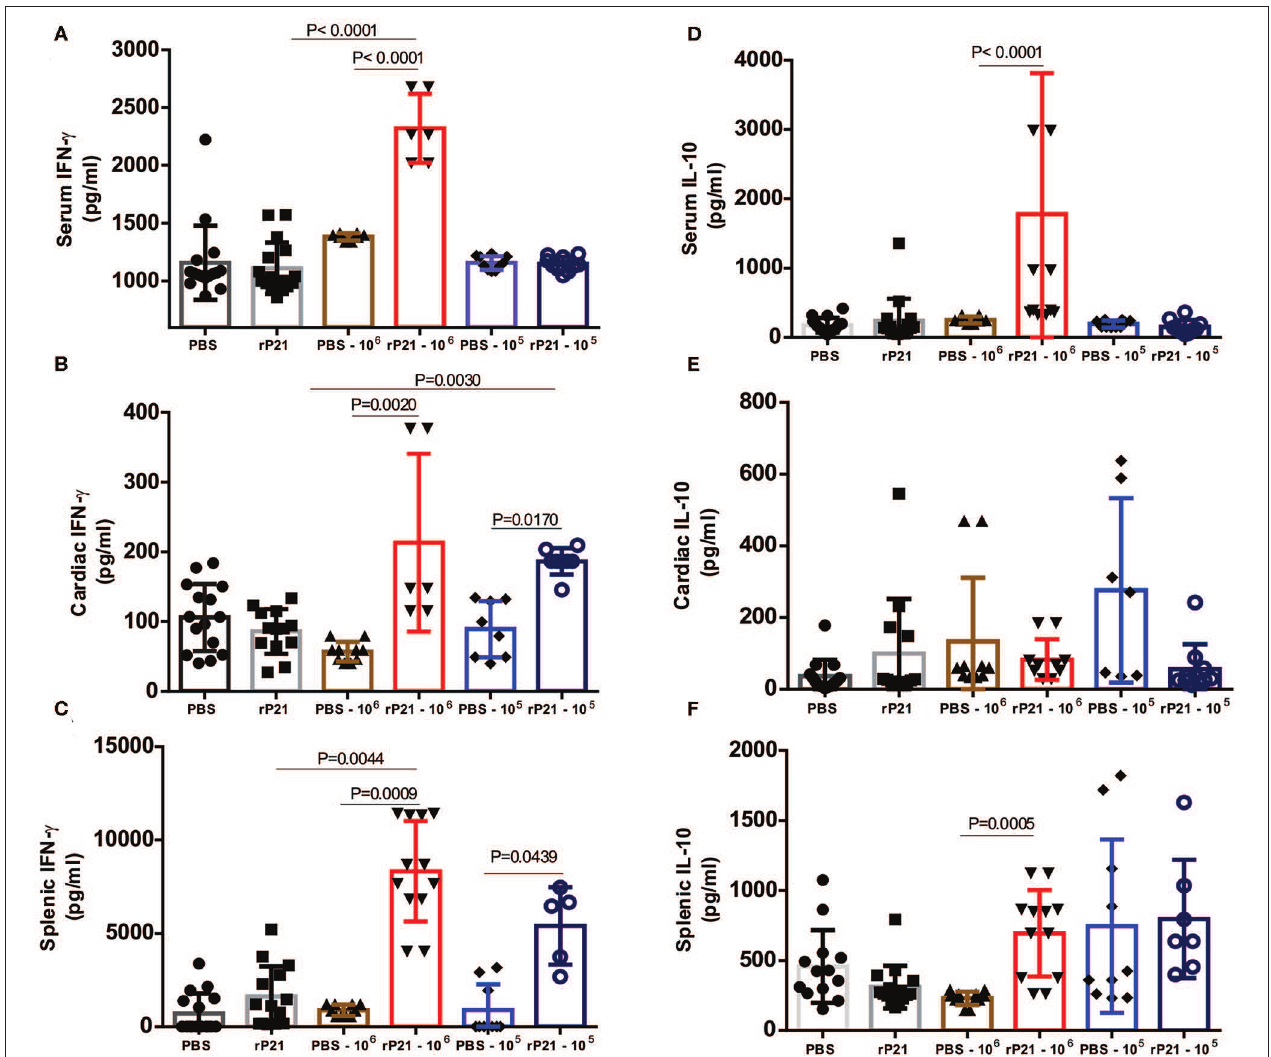
FIGURE 6 | Mice treated with rP21 presented higher levels of IFN- γ and IL-10. (A) Infected mice treated with rP21 show higher levels of IFN- γ in serum, (B) heart and (C) spleen. (D) There are no significant differences in the levels of IL-10 in serum and (E) heart of infected mice treated with PBS or rP21, but the levels are up-regulated in (F) splenic tissue of rP21-treated mice. Data are expressed as mean ± standard deviation of experiments performed in triplicate. Significant differences were determined using Kruskal–Wallis and Dunn’s multiple comparisons test. Differences were considered significant when p <